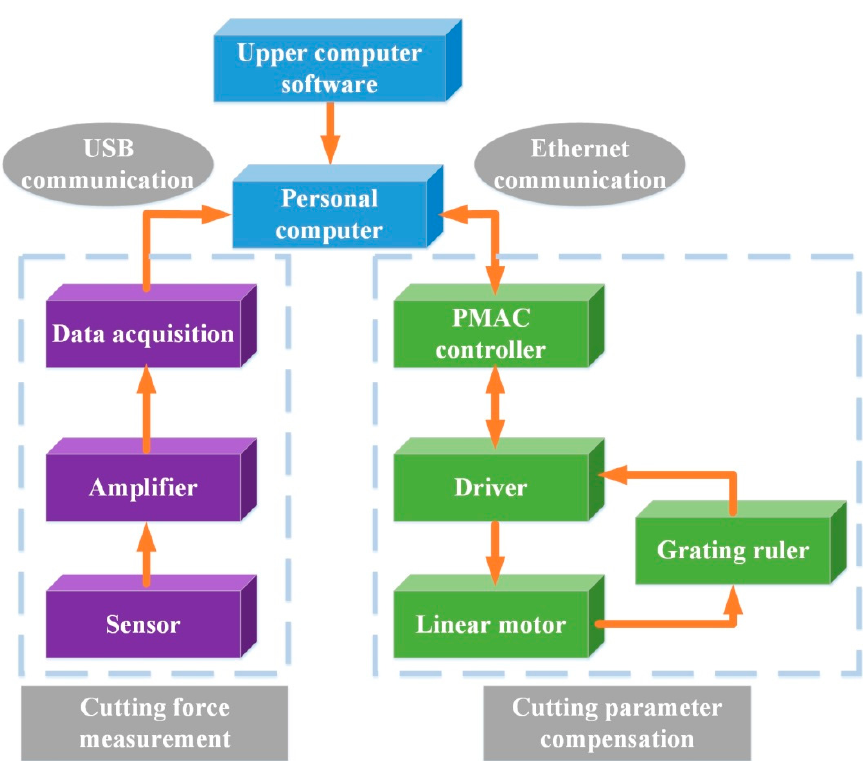
Figure 3. Control system diagram of the proposed device.